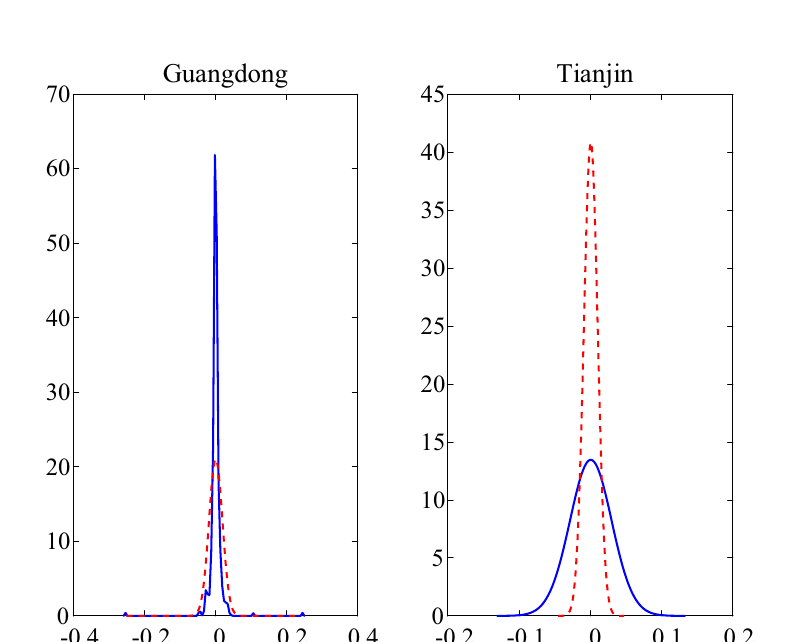
Fig. 4 Empirical distribution of daily trading prices of carbon allowances. Note: The solid line indicates the kernel estimate, and the dashed line indicates the Gaussian